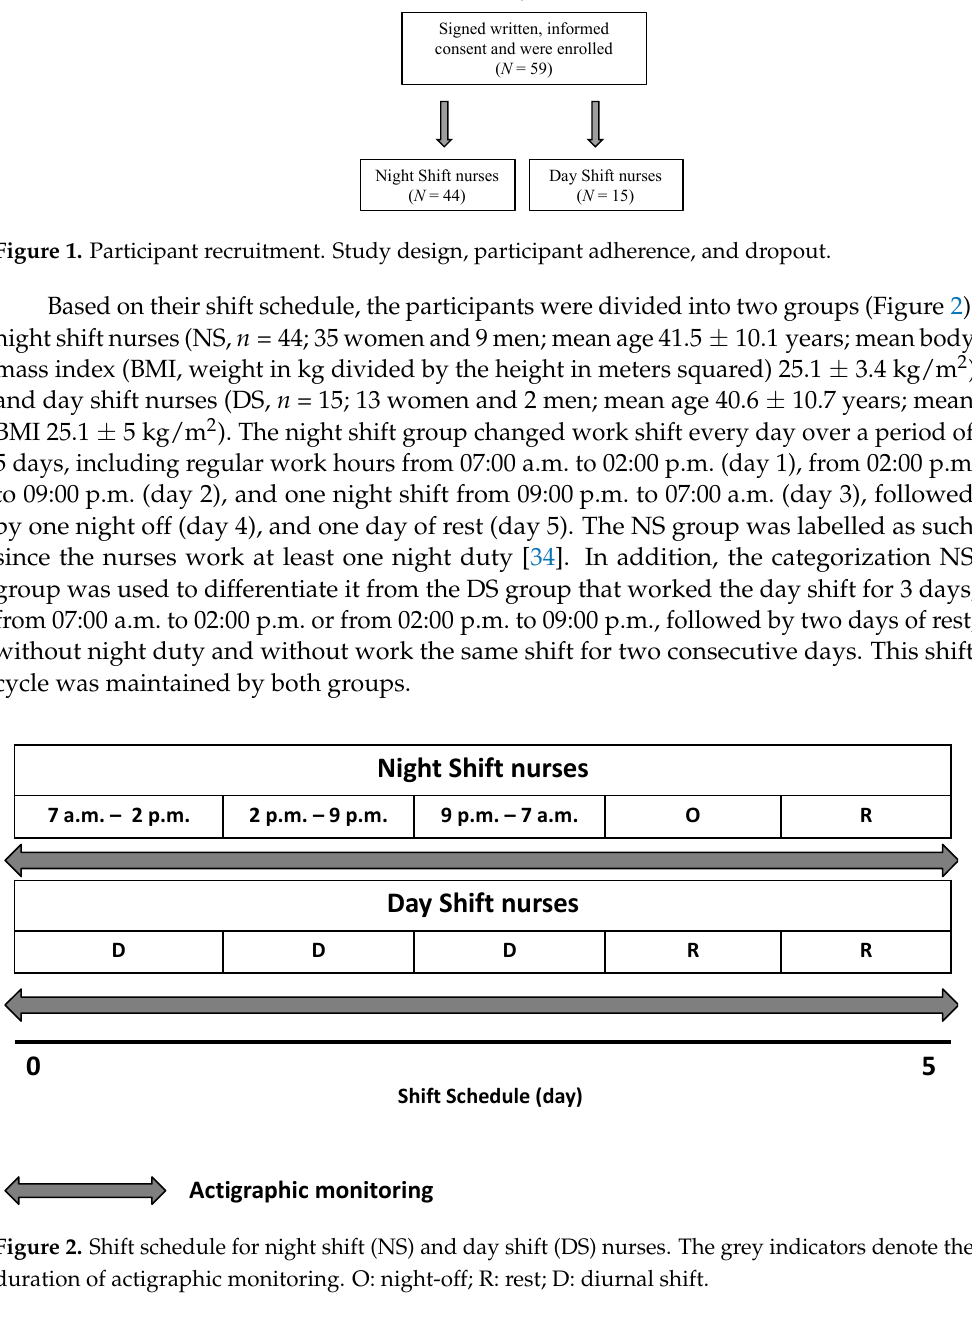
Figure 1. Participant recruitment. Study design, participant adherence, and dropout.